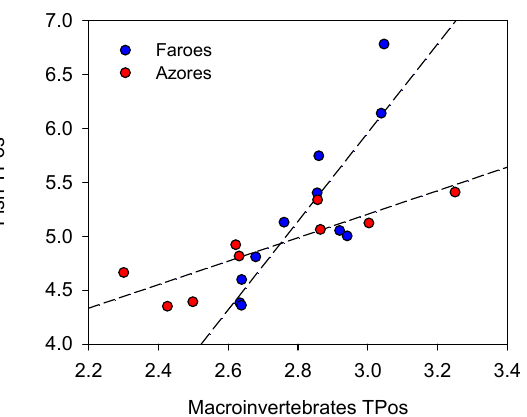
Figure 8. Relationship between the trophic position of fish and the trophic position of basal organisms in lakes in the Azores (red) (y = 1.34x + 1.15; R² = 0.69; p < 0.05) and the Faroe Islands (blue) (y = 4.10x − 6.35; R² = 0.74; p < 0.05).